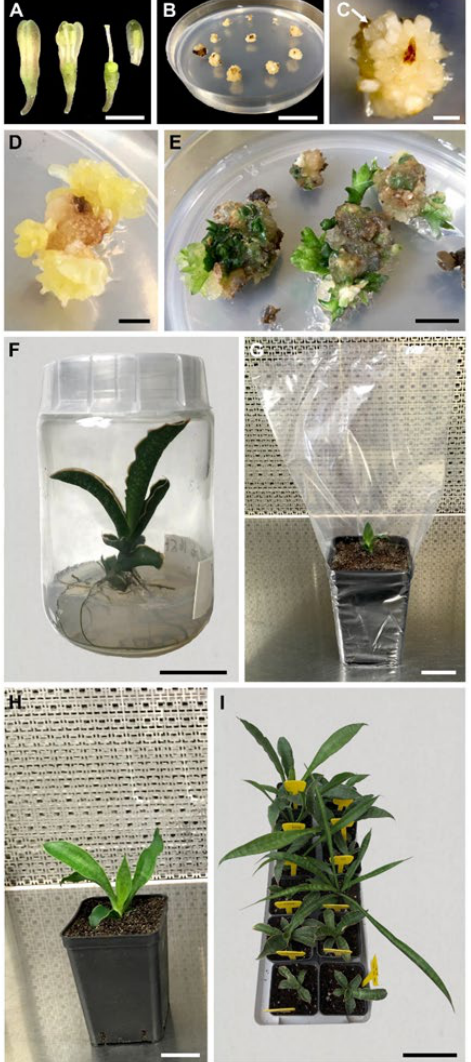
Figure 2. Plant regeneration in Sansevieria through somatic embryogenesis. ( A ) Sansevieria flower collected before opening and cut open under sterile conditions. From left to right: whole flower; flower with two petals removed; flower with all petals removed and stigma/style (Sti/Sty) and ovary (Ov) emphasized; anther and filament (Ant/Fil) explants dissected from Sansevieria flowers collected before opening (bar = 4 mm); ( B ) Creamy-white callus from the Sti/Sty explants (S-CNR-054) 90 days after culture initiation (bar = 1.5 cm); ( C ) Somatic embryos (S-CNR-054) generated after 120 days of culture initiation at the surface of anther explant-derived callus (bar = 2.5 mm); ( D ) Somatic embryos (S-CNR-103) generated after 150 days of culture at the surface of Ov explant-derived callus (bar = 2 mm); ( E ) Somatic embryos (S-CNR-103) generated after 200 days of culture initiation at the surface of Sti/Sty explant-derived callus (bar = 1.5 mm); ( F ) Plant (S-CNR-036) derived from germinated somatic embryos growing in Magenta jars for 150 days on MS medium (bar = 2.5 cm); ( G , H ) Somatic embryo-derived plant of S-CNR-074 transferred to sterilized soil and incubated in a growth cham- ber, respectively 14 and 60 days after acclimatization (bar = 3 cm); ( I ) Regenerated plants after two months of growth under greenhouse conditions (bar = 10 cm).